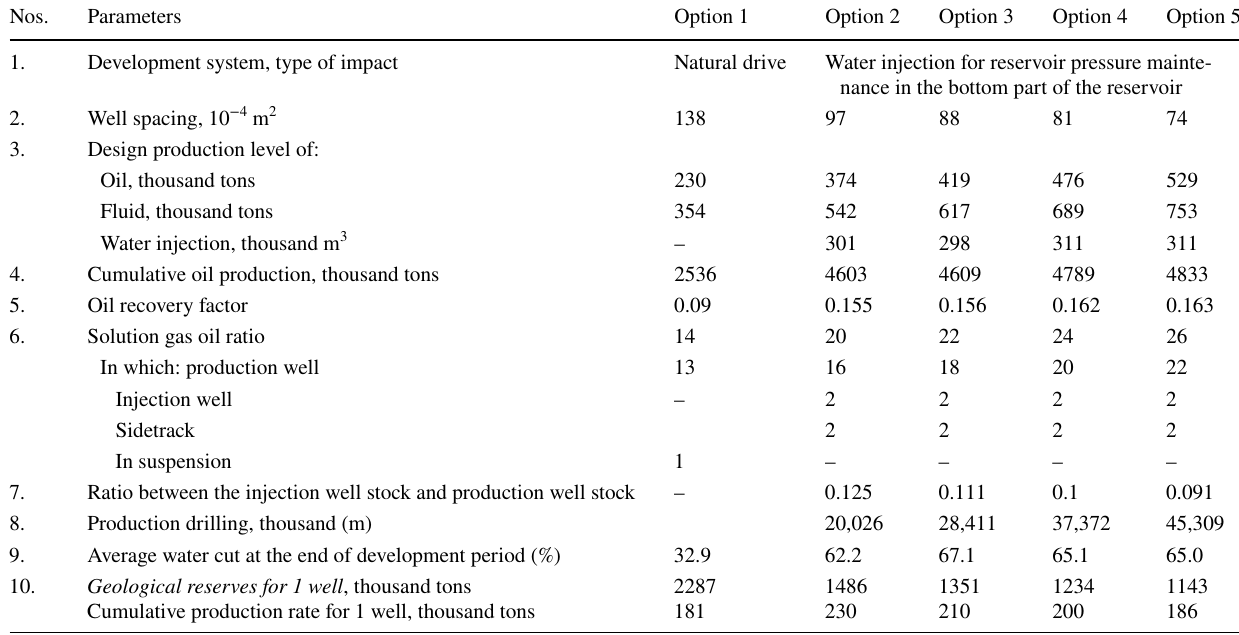
Table 3 Summary of technological parameters of the calculated options